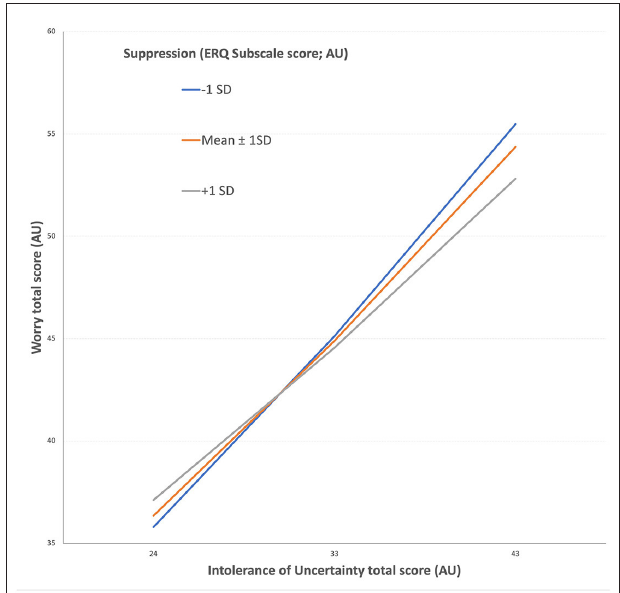
FIGURE 2 | Suppression (Emotion Regulation Questionnaire subscale, ERQ) moderates the relationship between Intolerance of Uncertainty (X axis) and Worry (Y axis). The figure displays the relationship between worry and intolerance of uncertainty among those with low, mid, and high levels of suppression. In low to medium levels of intolerance of uncertainty, high and low suppression groups don’t show significant differences in worry, but in high levels of intolerance of uncertainty, higher suppression is associated with lower worry, while lower suppression is associated with higher levels of worry. AU, Arbitrary